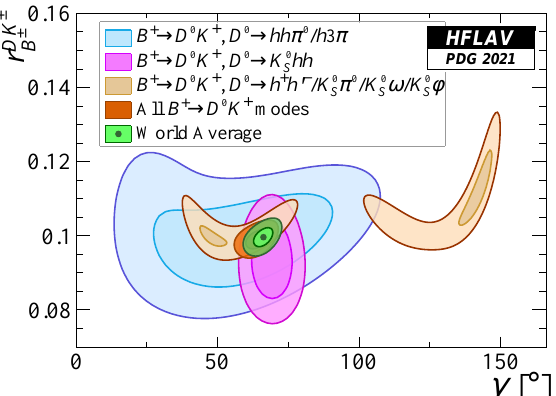
Figure 15: Constraints on the CKM unitarity angles γ and the ratio of decay ampli- ± obtained from the combination of multiple measurements [ 145,146 ] with tudes r DK B ± the GammaCombo framework [ 164,165 ]